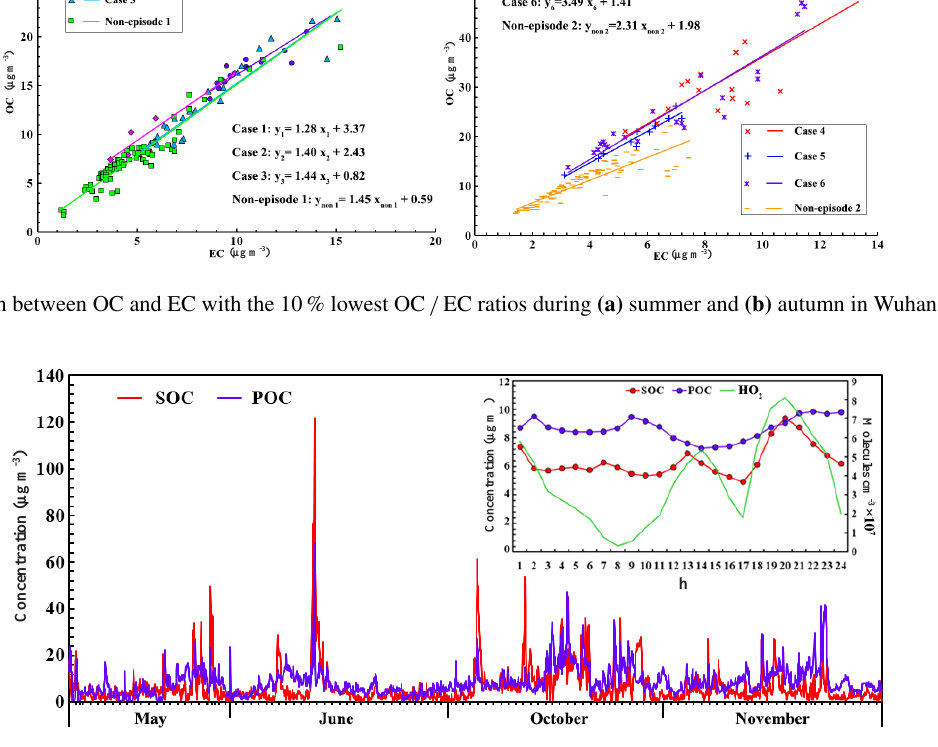
Figure 6. Hourly concentrations of SOC and POC. Insert graph presents average diurnal variations of SOC, POC, and HO 2